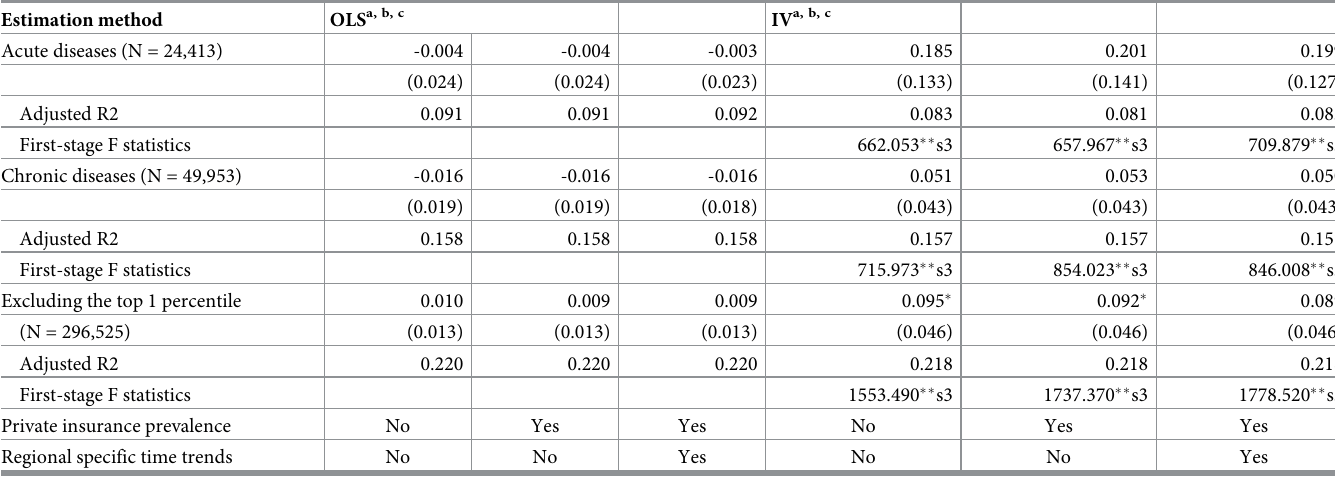
Table 3. Estimated arc elasticities by specific health